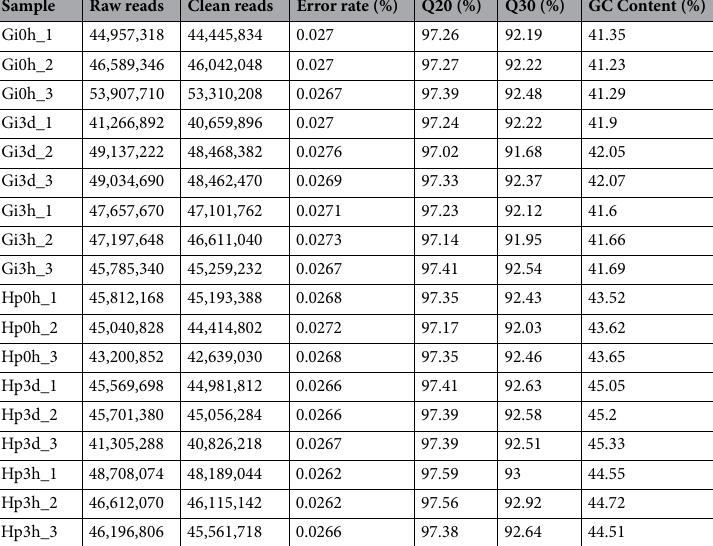
Table 1. Summary of the sequencing data. Error rate (%): Percentage of the error bases; Q20: percentage of bases with a Phred value > 20; Q30: percentage of bases with a Phred value > 30. GC (%): percentage of bases G and C number in the total number of